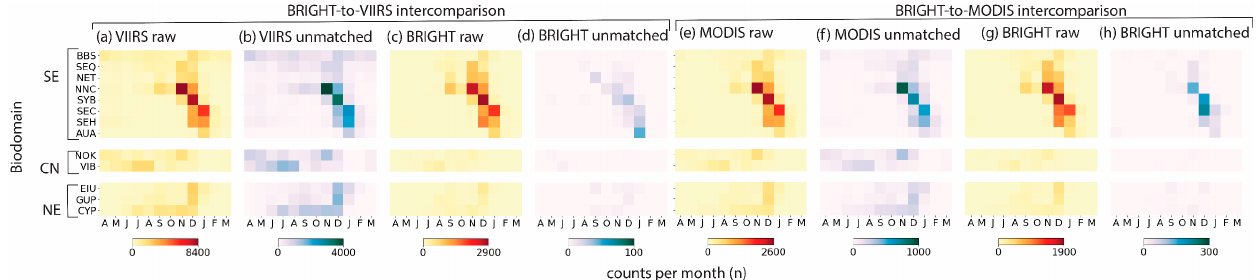
Figure 8. Same as Figure 7 except for the night sample.